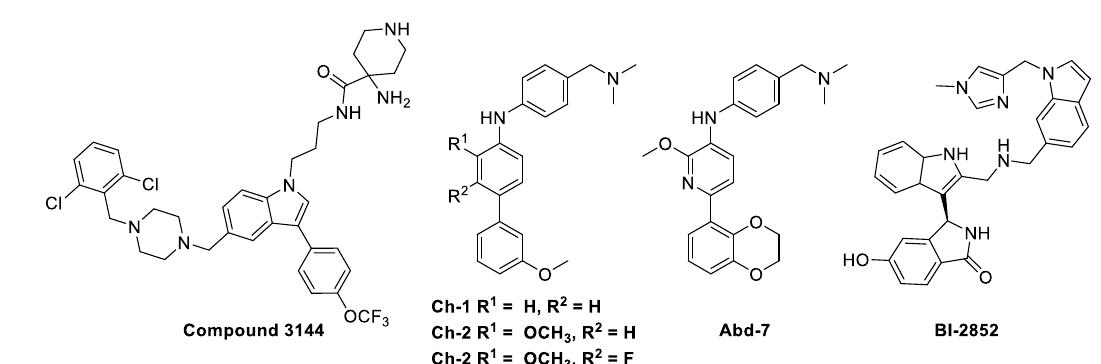
Figure 2. Chemical structures of direct inhibitors of RAS showing the ability to bind to the conserved RAS–effector interaction sites.